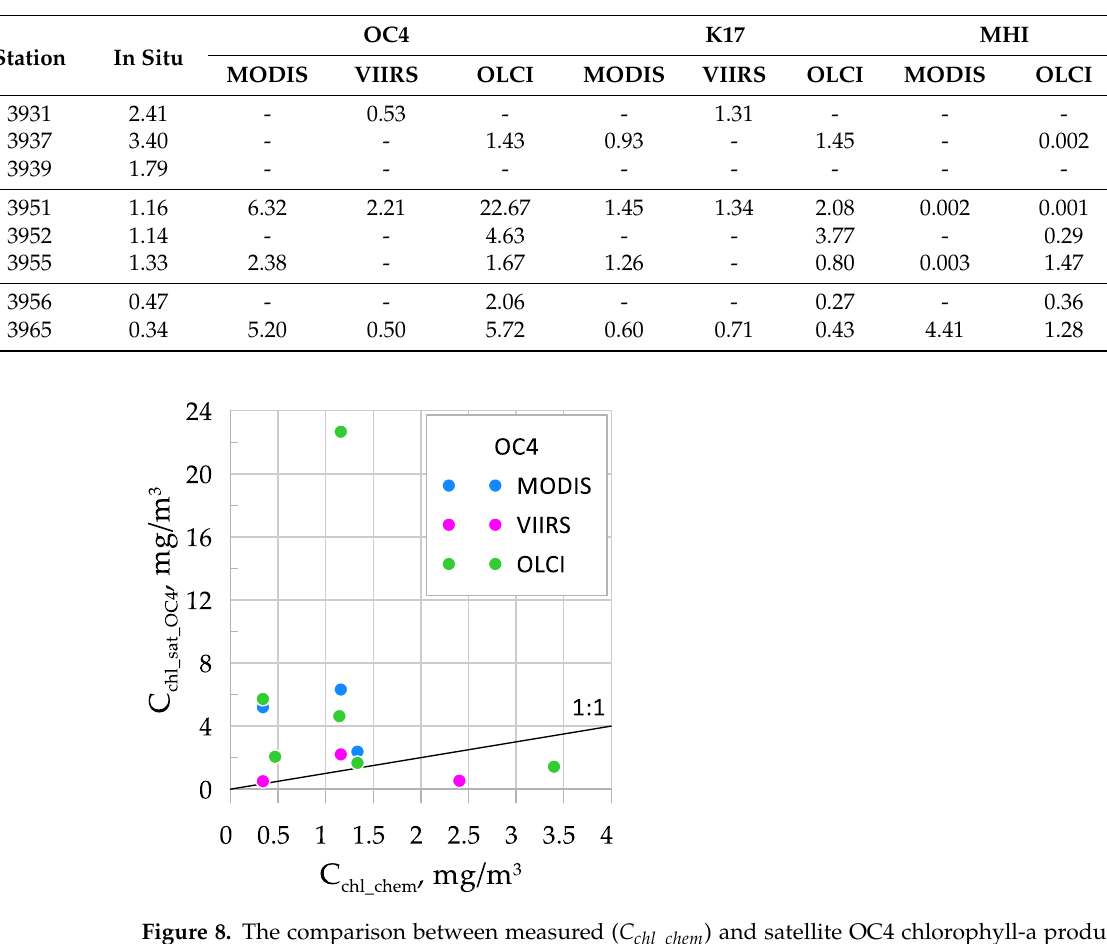
Table 3. Chlorophyll-a concentrations (mg/m 3 ) provided as standard satellite product (OC4) and calculated using regional algorithms (K17 and MHI) from satellite Rrs data.